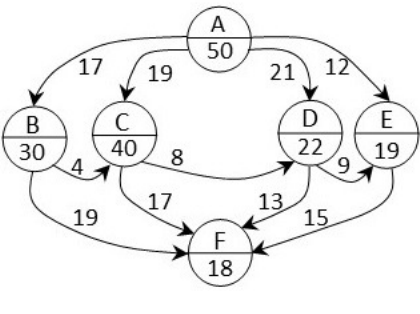
Figure 2. A first six-node Directed Acyclic Graph (DAG) task.